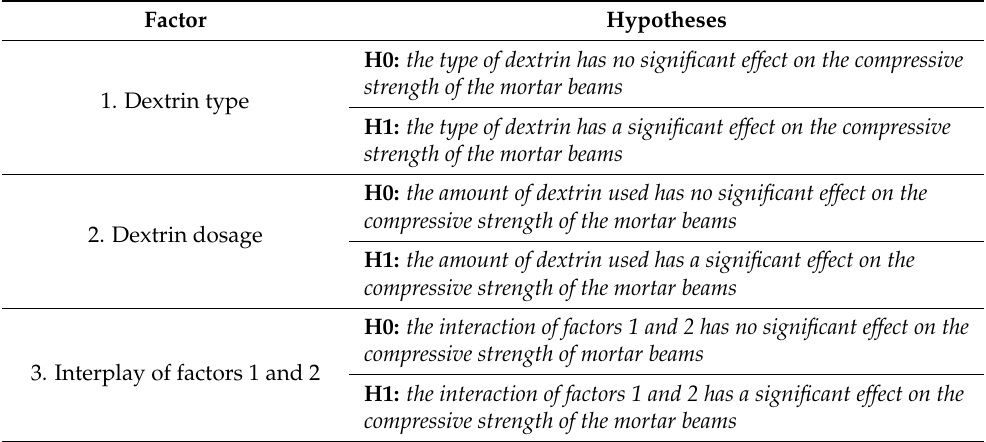
Table 5. Research hypotheses for mortar beams doped with dextrins d2, d3, and d5.